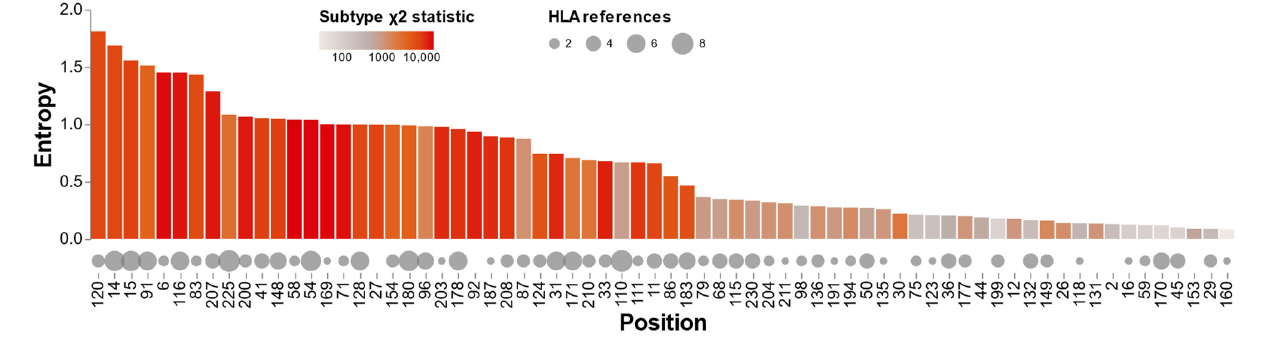
Figure 4. Correlation between Shannon’s entropy, the logarithm of the subtype Chi-Square statistic, and the number of studies reporting that a position was associated with an HLA-associated polymorphism among the 70 capsid positions containing one or more mutation with a prevalence ≥ 1.0%.